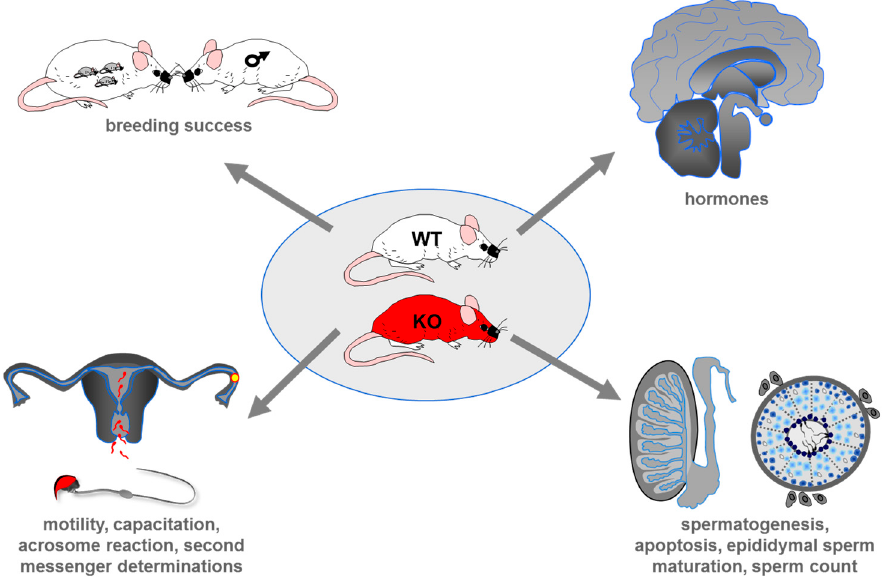
Figure 4. Experimental strategy to determine the impact of taste receptors for male reproduction. To gain a complete picture about a possible role of taste receptors for regulating male reproduction standard reproductive parameters (e.g., litter size, time to litter, sex ratio of pubs) were determined for breeding pairs of wild-type [WT] and taste receptor deficient animals [KO]. To evaluate whether genetic deletion of taste receptors affect spermatogenesis results of breeding experiments were supplemented by histopathological examinations of reproductive organs and isolated epididymal sperm cells; furthermore, reproductive-related hormones such as testosterone, LH, FSH and GnRH were quantified. To evaluate whether a loss of taste receptors modifies physiological sperm function, CASA (computer-assisted motility analysis) -based motility analyses were combined with experiments assessing the ability of sperm to respond to capacitation and acrosomal exocytosis stimuli.